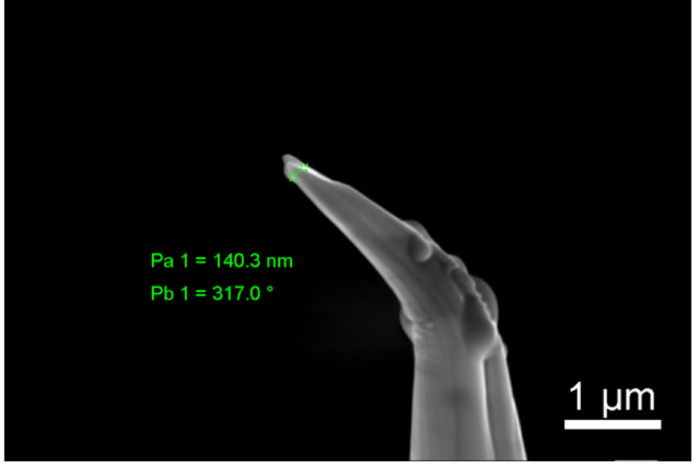
Figure 3. Example of the fractured APT